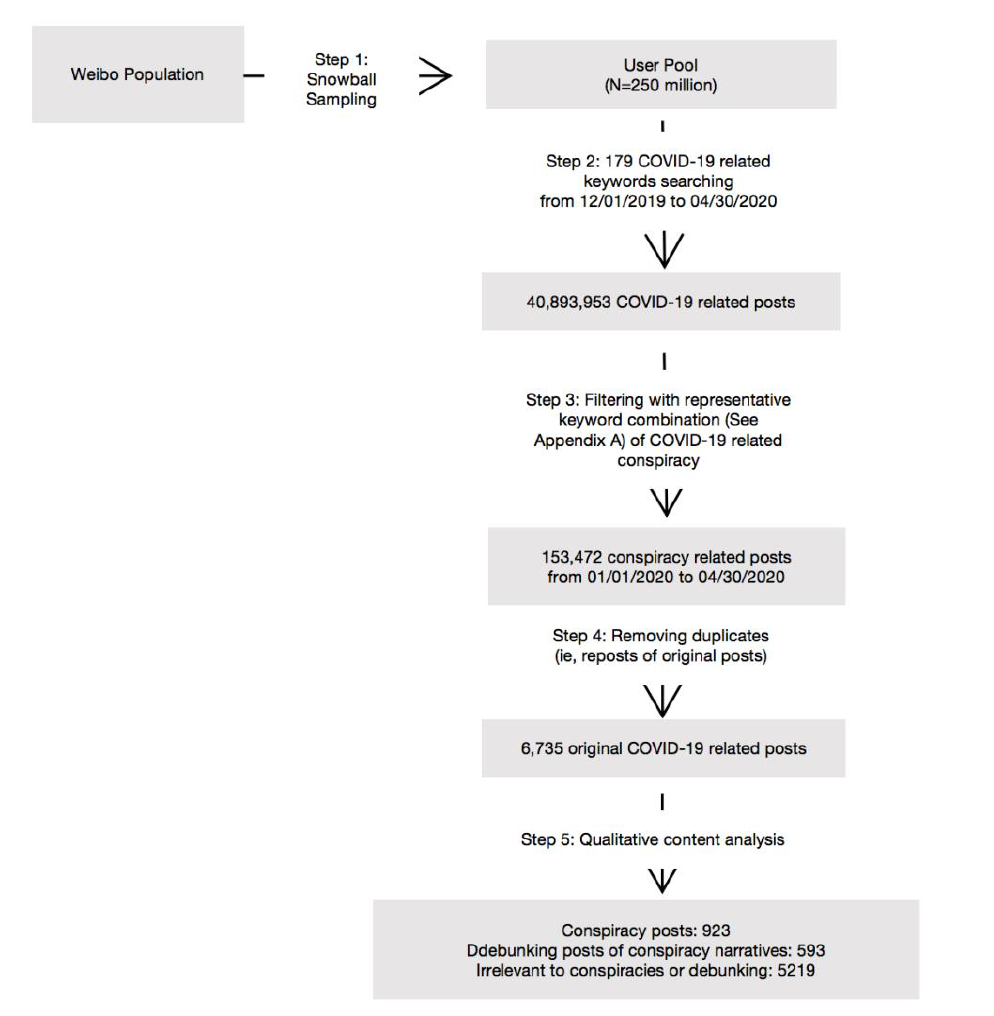
Figure 5. Weibo data collection and content analysis